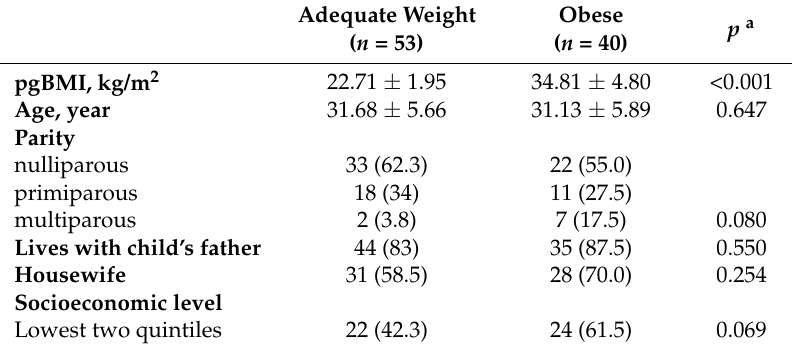
Table 1. Maternal characteristics.